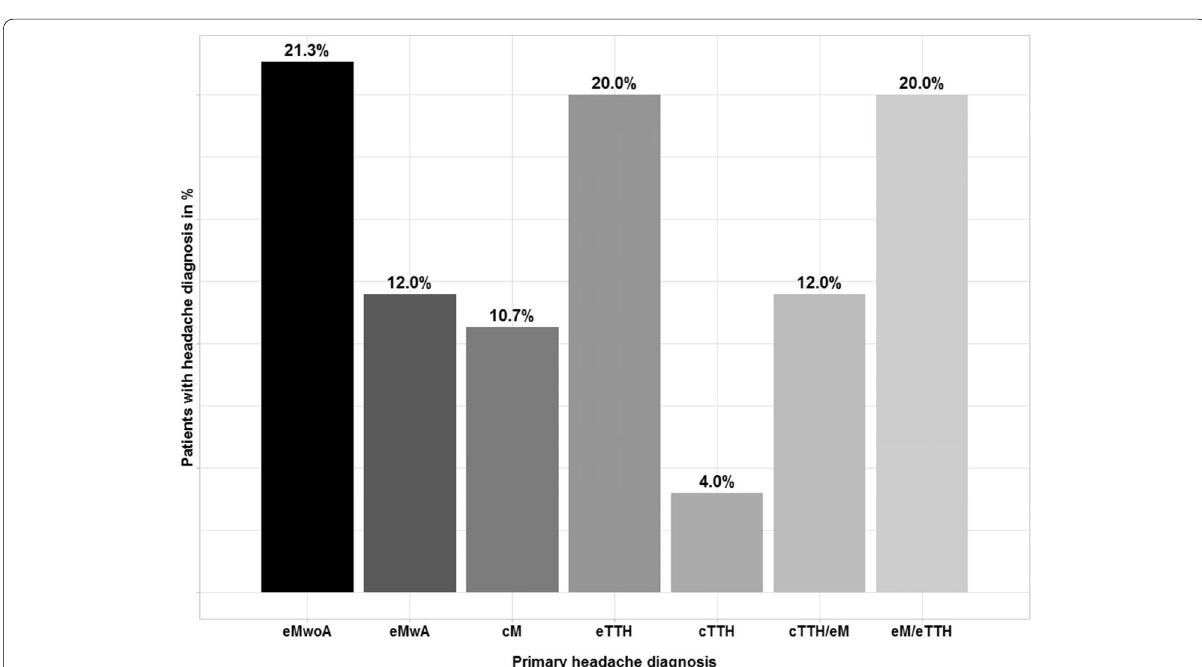
Fig. 2 Primary headache diagnoses of patients in the program. 16 patients (21,3%) episodic Migraine without Aura (eMwoA), 9 patients (12%) episodic Migraine with Aura (eMwA), 8 patients (10,7%) chronic Migraine (cM), 15 patients (20%) episodic Tension Type Headache (eTTH), 3 patients